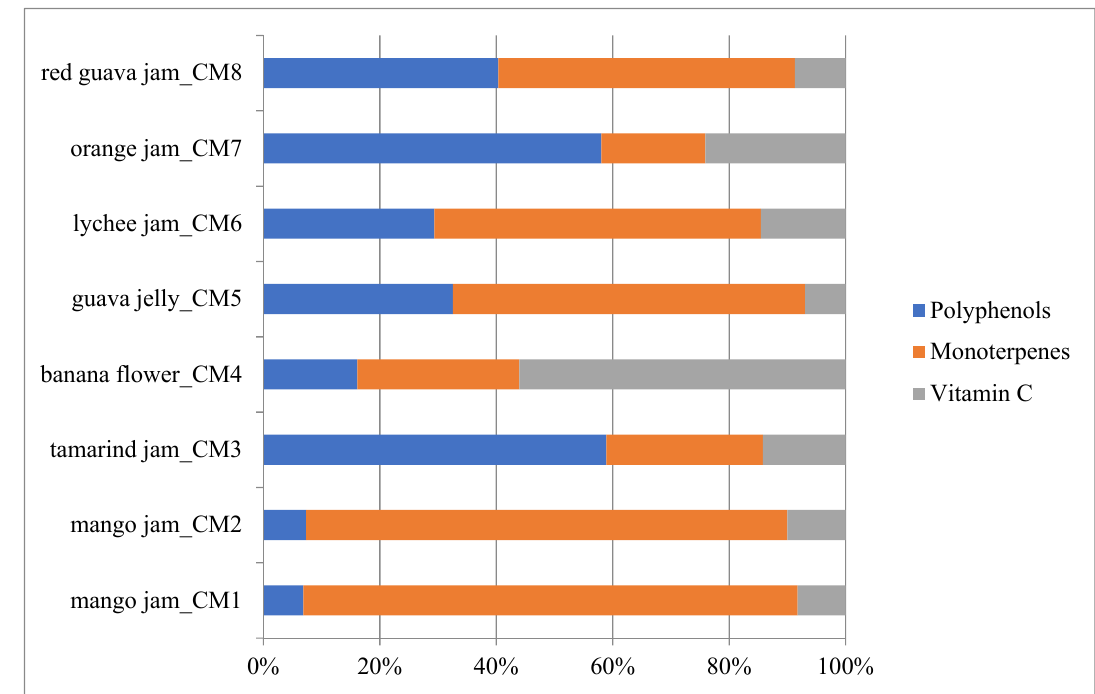
Figure 1. Phytocomplex representation of analysed fruit ‐ derived products. The mean value of each analysed sample is given ( N = 3).